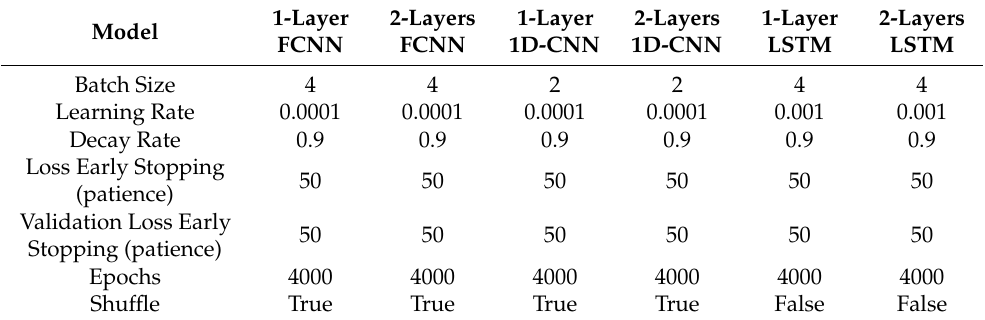
Table 2. Fitting parameters of the